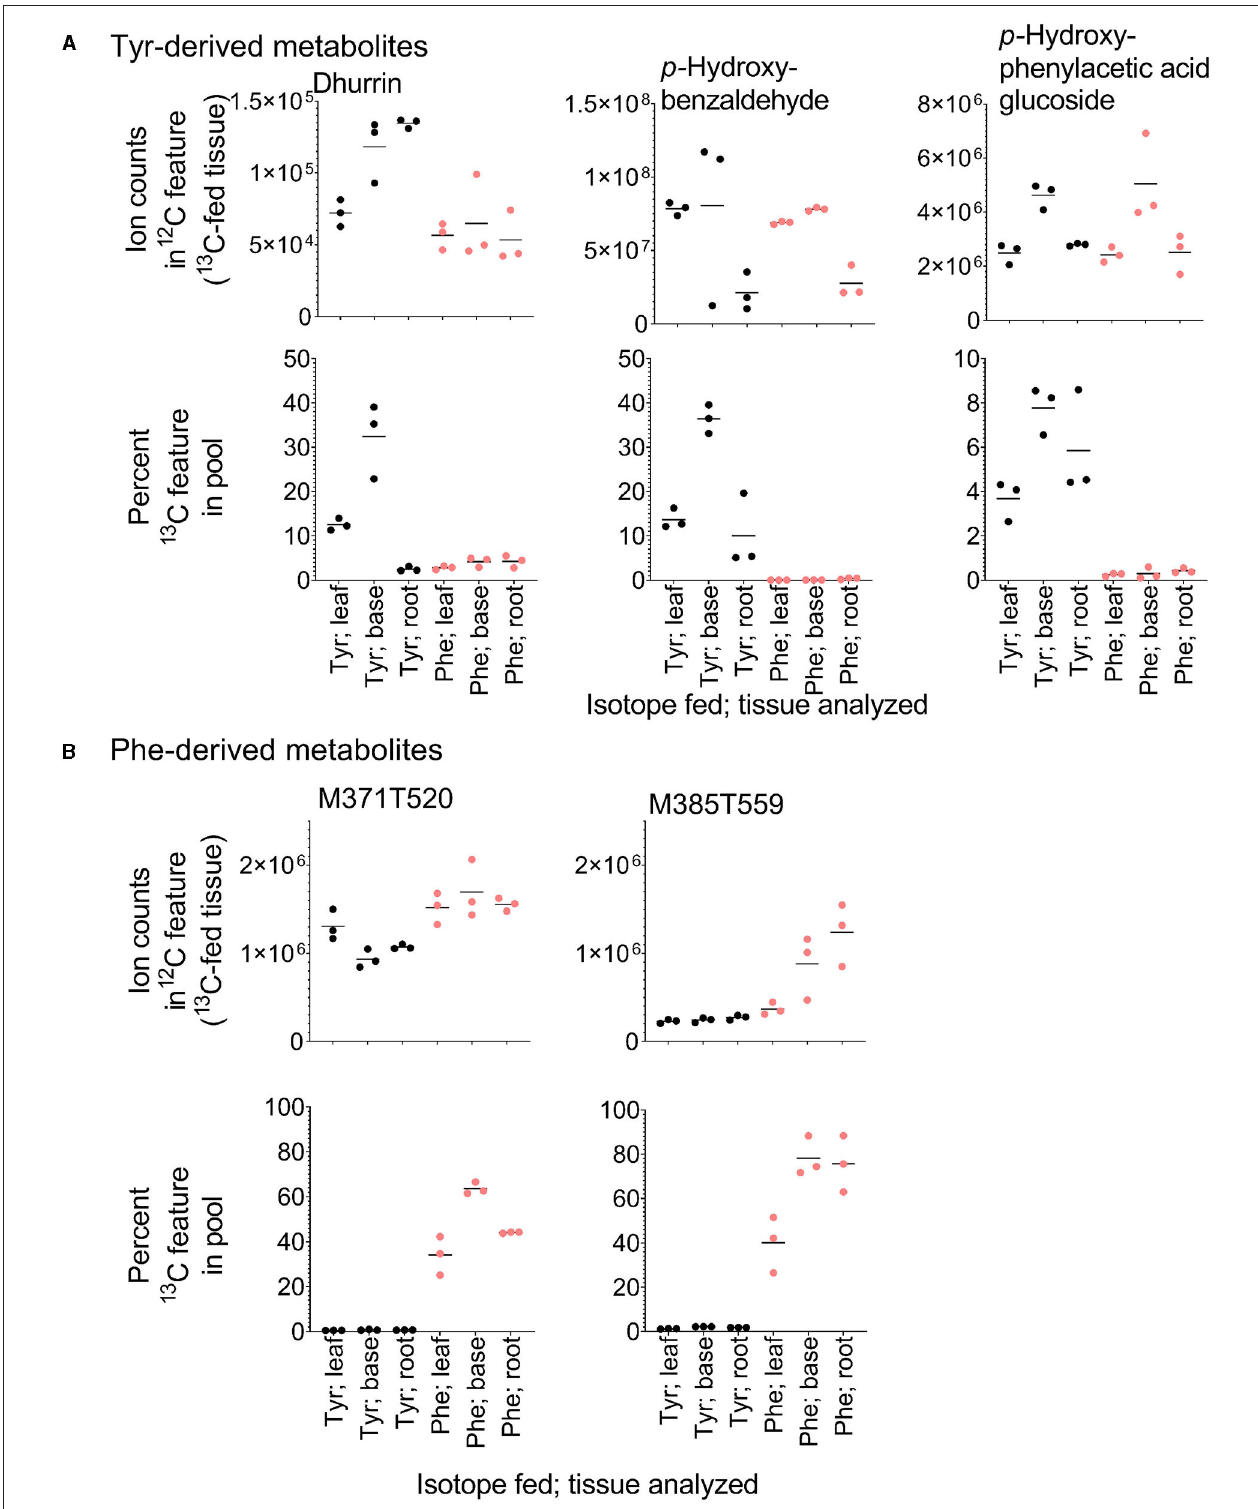
FIGURE 6 | Relative quantification and heavy isotope incorporation into exclusive Tyr- and Phe-derived metabolites from the different tissues and feeding regimes. (A) Ion counts into the Tyr-derived features dhurrin, p- hydroxybenzaldehyde, and p- hydroxyphenylacetic glucoside in tissues fed with each 13 C isotope (top) and the percent of the dhurrin, p- hydroxybenzaldehyde, and p- hydroxyphenylacetic glucoside pools that are represented by their respective de novo synthesized 13 C-containing features (bottom). (B) Accumulation and labeling into two exclusive Phe-derived features. M371T520 and M385T559 have MS/MS spectra consistent with being esters of benzoic acid and phenylacetic acid,